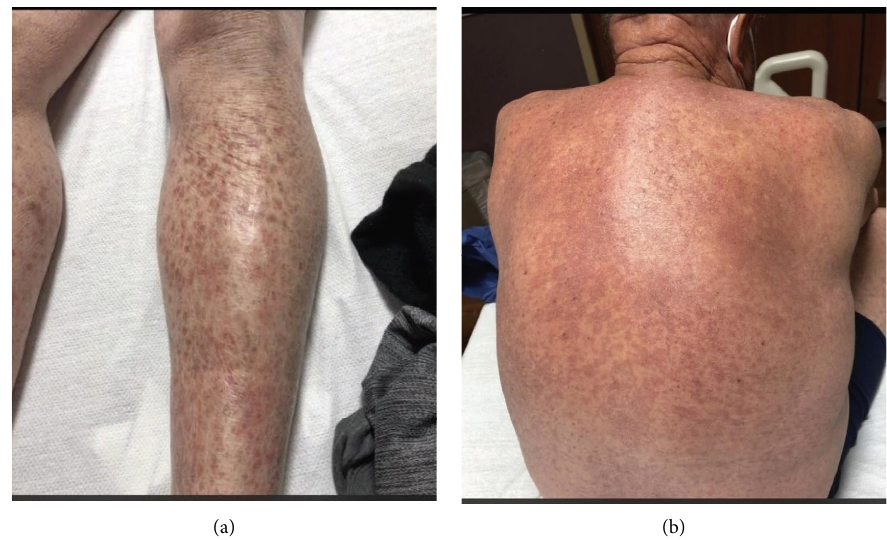
Figure 1: (a) Bilateral purpura of the limbs demonstrating small-vessel vasculitis. (b) Purpura of the posterior thoracic and lumbar